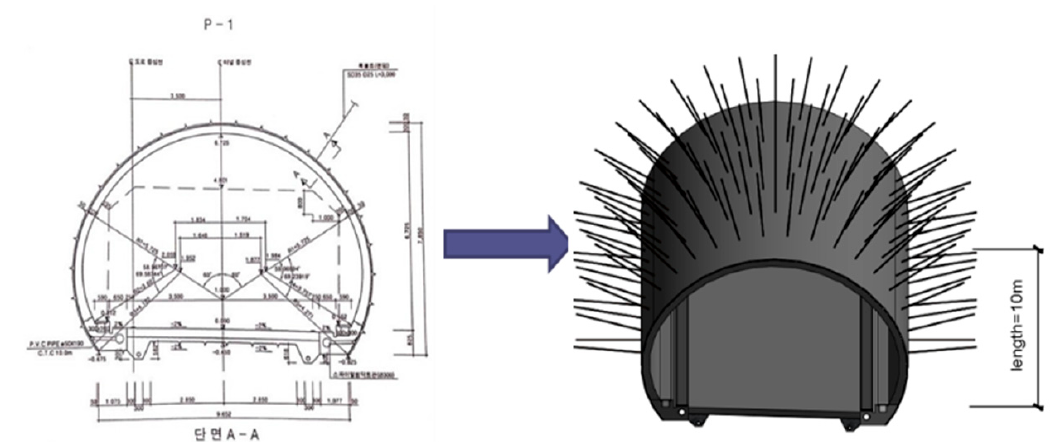
Figure 3. 2D tunnel cross on drawings ( left ), 3D tunnel model section ( right ).